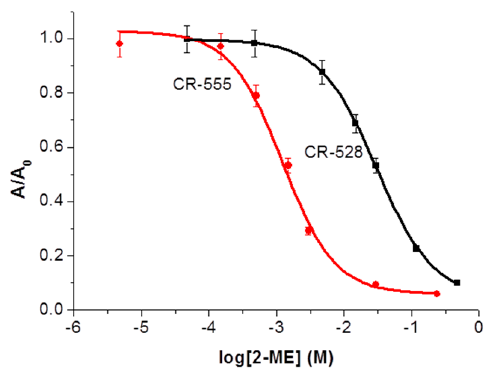
Figure 4. Spectrophotometric titrations of CR-528 and CR-555 in ethanol as a function of mean normalized absorbance maximum (taken at 528 nm for CR-528 nm and at 555 nm for CR-555). Each data point represents an average value of three measurements. Error bars show standard error.